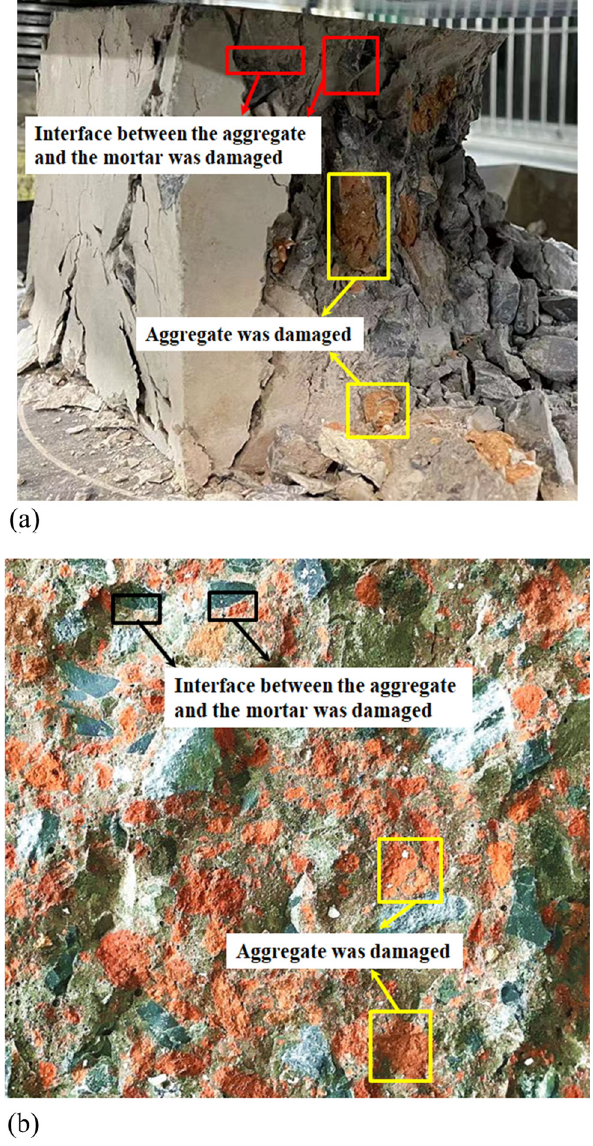
Figure 10: Morphology of RBC. ( a ) Morphology of AFt and ( b ) Morphology of C – S –